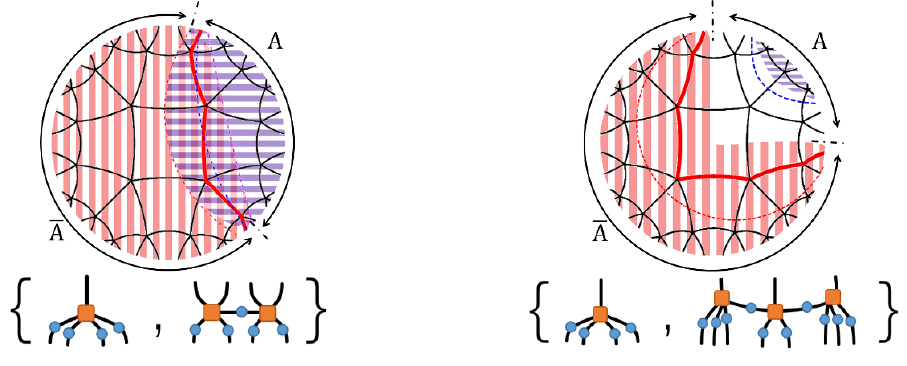
Figure 16 . The tensor network with f 4 ; 5 g tiling and S c =